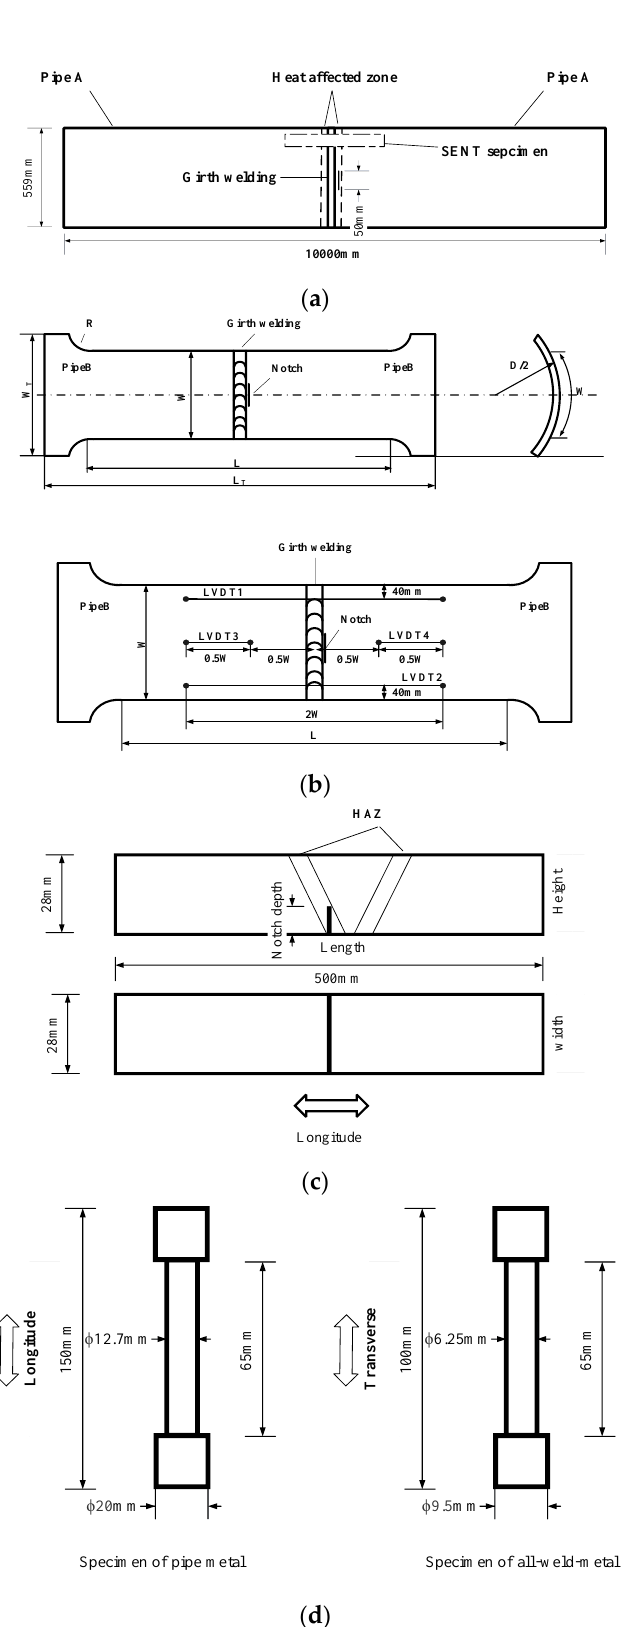
Figure 1. The size of SENT, tensile test and full-size hydrotest cuts from the high strain marine pipe. ( a ) The size of pipe used in the full-size bending test; ( b ) Specimen of CWP and the positions of extensometers; ( c ) Specimen of SENT test; ( d ) Tensile test specimens.